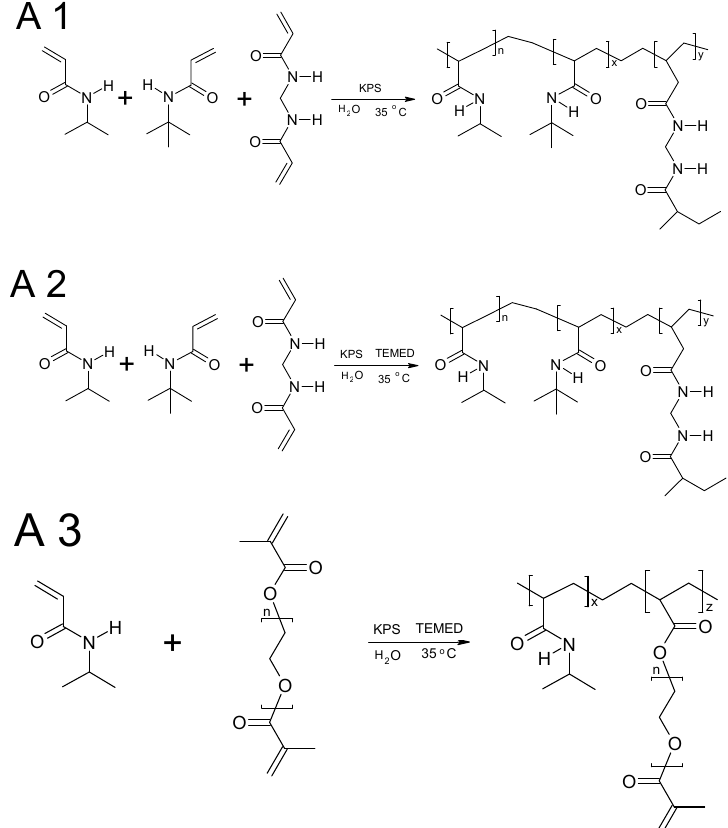
Figure 5. Proposed synthesis scheme of thermosensitive particles A1–A3. A1, A2 and A3 were synthesized at 35 °C; however the polymerization was activated by N,N,N’,N’ - tetramethylethylenediamine (TEMED) in the case of A2 and A3. A3 was crosslinked by poly(ethylene glycol) dimethacrylate (PEG-DMA) instead of N , N ’-methylene bisacrylamide (MBA) applied in A1 and A2.